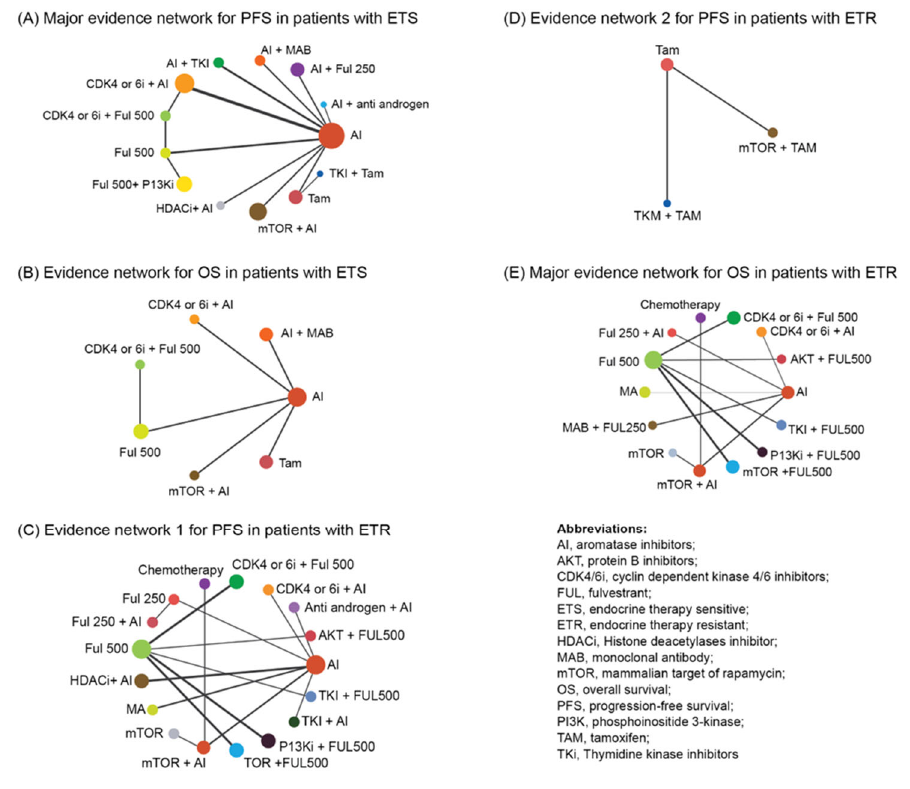
Figure 2. Network meta-analysis plots. ( A ) Major evidence network for PFS in patients with ETS; ( B ) Evidence network for OS in patients with ETS; ( C ) Evidence network 1 for PFS in patients with ETR; ( D ) Evidence network 2 for PFS in patients with ETR; ( E ) Major evidence network for OS in patients with ETR.